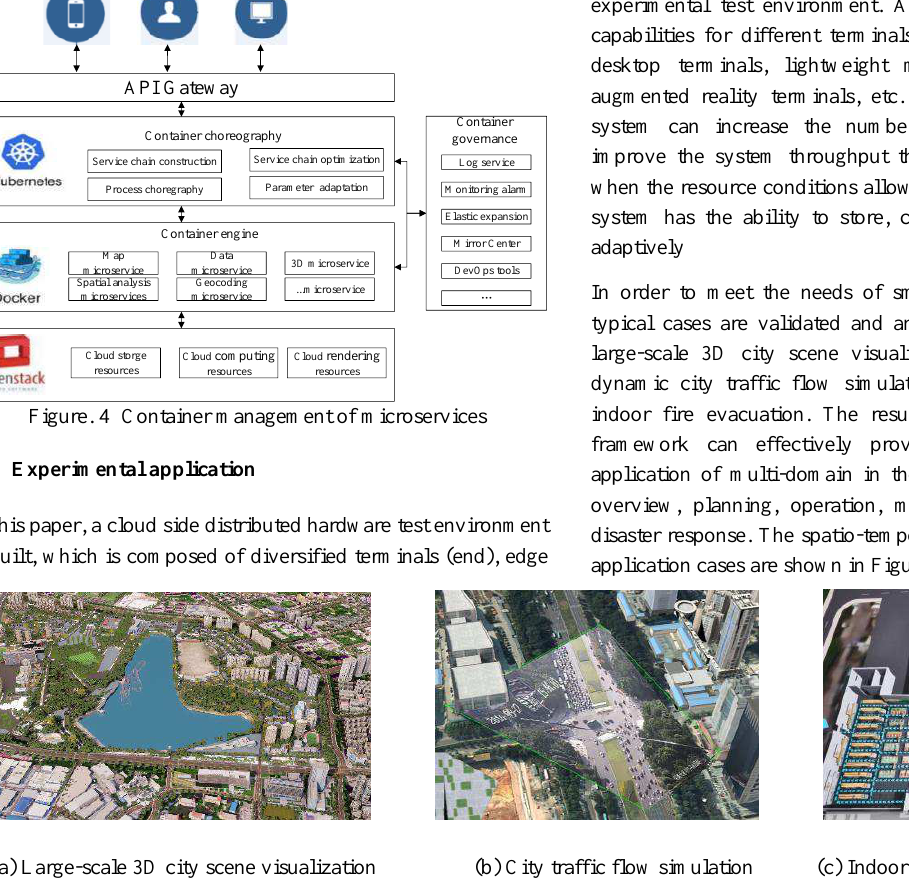
Figure. 5 The spatio-temporal multi-level visualization application